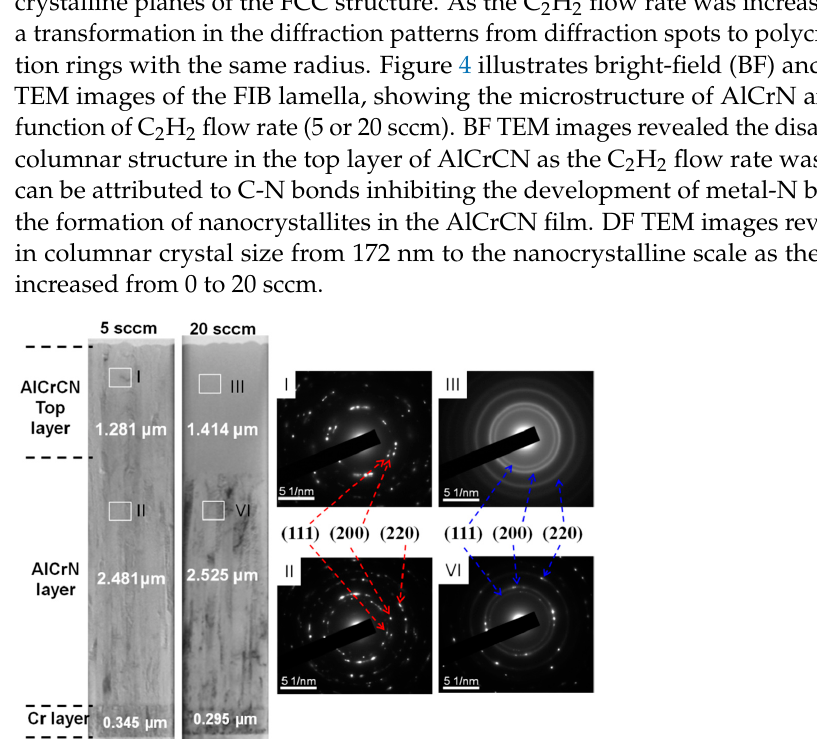
Figure 4. BF and DF TEM images of AlCrN and AlCrCN films. Figure 5 presents the hardness and Young’s modulus of AlCrCN films as a function of carbon content, as determined using nanoindentation measurements. When the C 2 H 2 flow rate was increased from 0 to 20 sccm, we observed an initial increase in the hardness (from 19.1 to 28.6 GPa) and Young’s modulus (318 to 358 GPa), both of which subse- quently decreased to 13.5 GPa and 212 GPa, respectively. The increased hardness of the AlCrN film can be attributed to a reduction in the size of the columnar crystals and grains, which restricted the displacement of dislocations, the propagation of cracks, and grain boundary sliding [8,36]. The AlCrCN film with the highest hardness presented fewer C- N and C=N bonds and a higher sp 3 /sp 2 ratio. We can see in the TEM image that the colum- nar crystals in AlCrCN film deposited with a C 2 H 2 flow rate of 10 sccm were smaller than that of films deposited under a flow rate of 5 sccm; however, the hardness was not as high. XPS results revealed that replacing a large number of metal − N bonds with C − N and C=N bonds resulted in an FCC structure with poor crystallinity. The main effect of hardness should come from the C-N bond inhibiting the development of metal-N bonds, leading to the formation of nanocrystallites in the AlCrCN film.